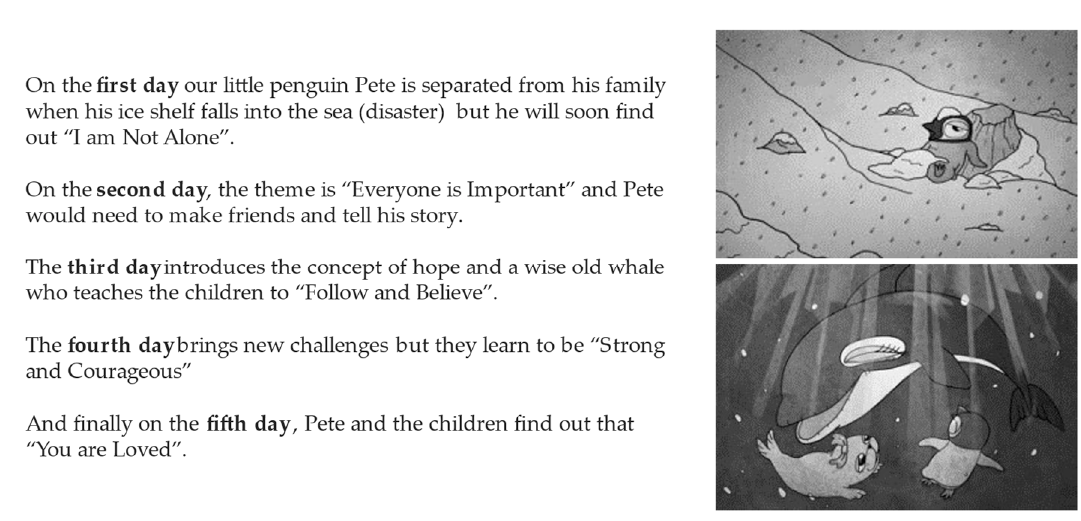
Figure 1. O p erationSAFE’s Pete the Penguin teaches 5 principles of MHFA. Figure 1. OperationSAFE’s Pete the Penguin teaches 5 principles of